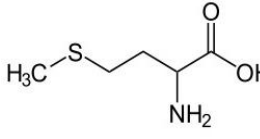
Figure 2. A scheme of the molecular structure of methionine.